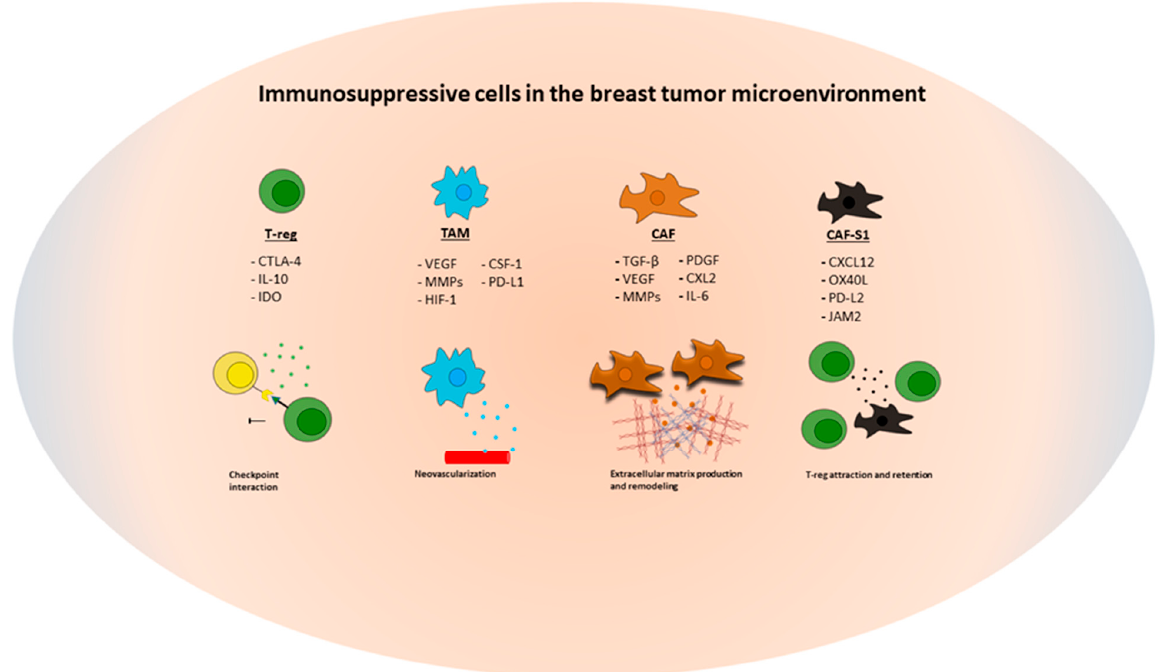
Figure 1. Illustration of the immunosuppressive cell types in the breast tumor microenvironment discussed in this review with a selection of the most common molecules and mechanisms of action that promotes tumor growth. Abbreviations used for cell types and signaling molecules: CAF (cancer-associated fibroblasts); CAF-S1 (cancer-associated fibroblasts—subtype 1); TAM (tumor- associated macrophages); T-reg (regulatory T-cells); CSF-1 (colony-stimulating factor 1); CTLA4 (cytotoxic T-lymphocyte-associated); CXCL (C-X-C motif chemokine); HIF-1 (hypoxia-inducible factor 1); IDO (Indoleamine 2,3-dioxygenase); IL (interleukin); JAM2 (junctional adhesion molecule 2); MMP (matrix-metalloproteinase); OX40L (tumor necrosis factor ligand); (PD-L1/2 (programmed death ligand 1/2); PDGF (platelet-derived growth factor); TGF (transforming growth factor); VEGF (vascular endothelial growth